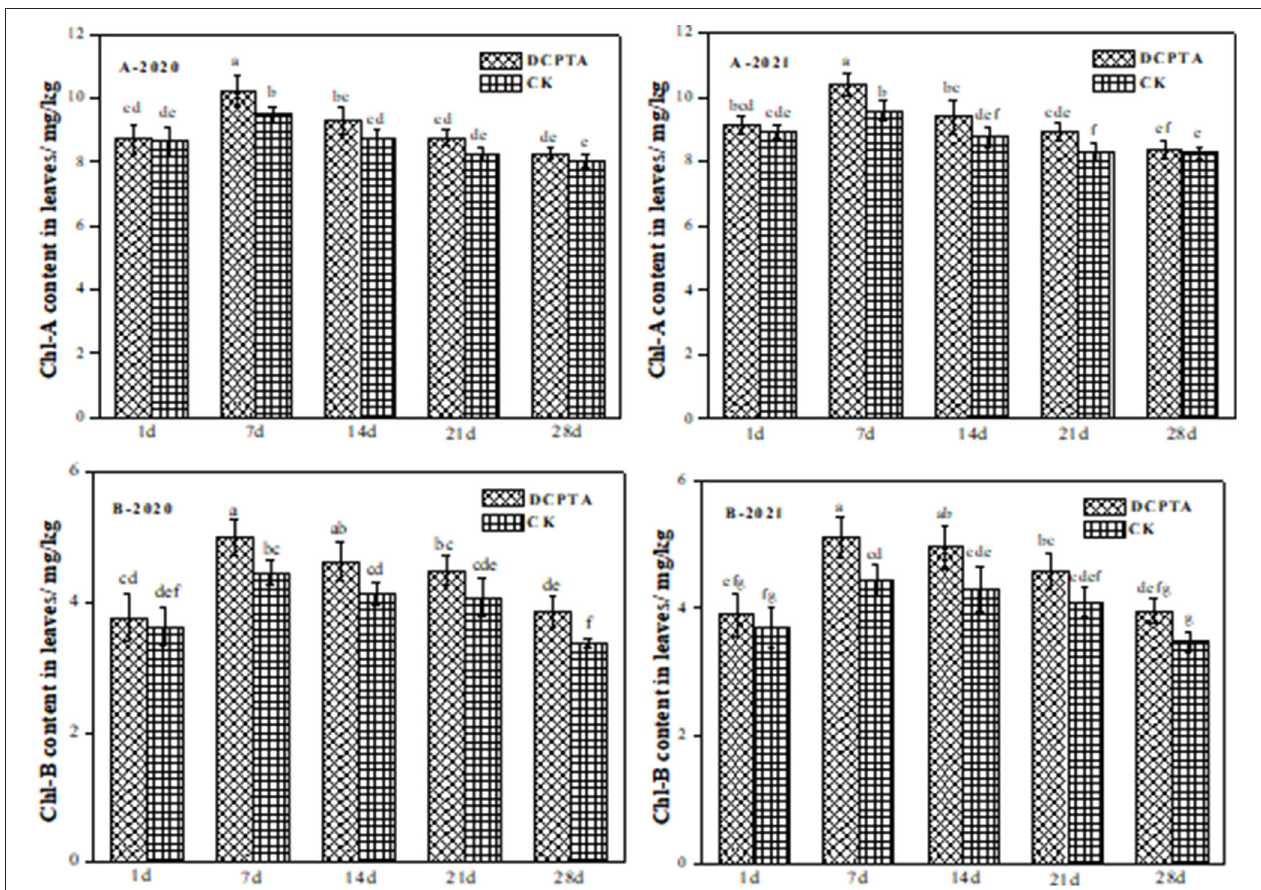
FIGURE 2 | The effect of Chl-A and Chl-B in leaves on days after spraying from 2020 to 2021. (A) Chl a content; and (B) Chl b content of leaves at 1–28 days after spraying in 2020 and 2021. Data were analyzed by ANOVA to separate significance. Vertical bars represent mean ± SE from three independent replicates and the different letters denote significant differences ( p <